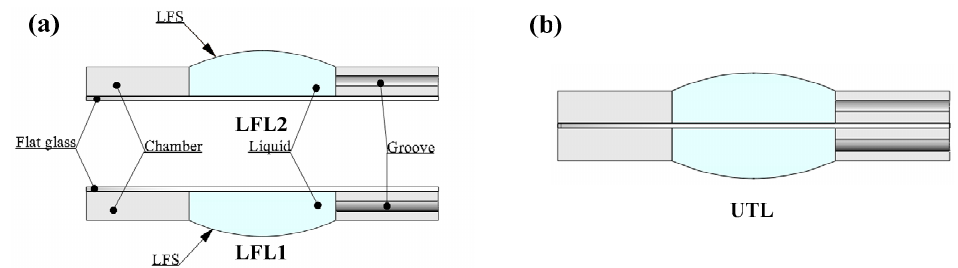
Figure 1. ( a ) Construction of the LFL, consisting of three main parts: chamber, flat glass, and liquid. ( b ) The cross-section of a fully assembled UTL.